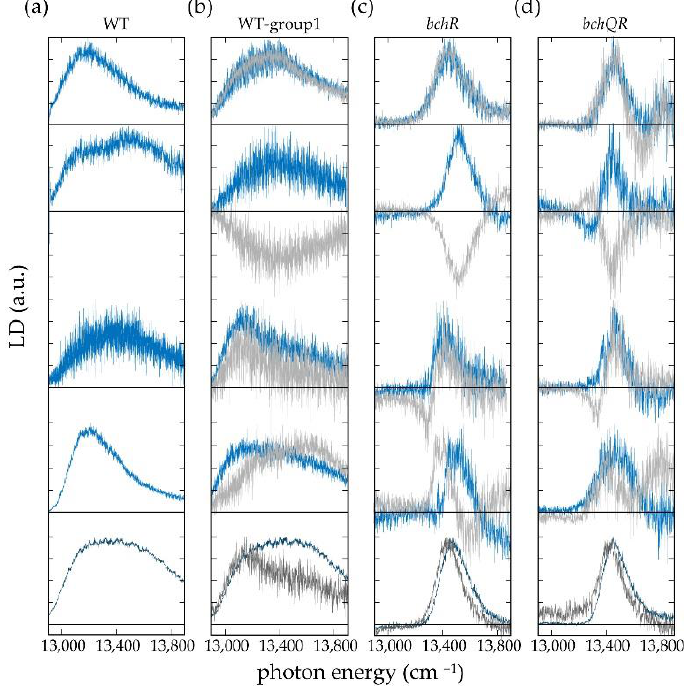
Figure 5. Reconstructed LD spectra using the central alignment direction obtained from the modulation of the fluorescence intensity at the maximum of the individual spectrum (light blue), or from the modulation of the Gaussian A 1 (light grey). The panel shows from left to right examples of LD spectra of individual chlorosomes from ( a ) WT, ( b ) WT-group1, ( c ) bchR , and ( d ) bchQR . The panel shows from top to bottom examples of LD spectra from individual chlorosomes that feature good agreement (A), good agreement but a sign flip (B), reasonable agreement (C), and no agreement for the two reconstruction methods (D). A–D refer to the classification used in Table 1. The spectra shown at the bottom in dark blue (dark grey) represent the corresponding ensemble spectra obtained by summing all individual LD spectra measured for chlorosomes of types ( a – d ) obtained according to method 1 (method 2). For each spectrum, the zero level is given by the horizontal line, and all spectra have been normalized for better comparison. Note in passing: For the WT chlorosomes, the comparison of the two reconstruction methods is not meaningful, because the spectral signatures of the WT-group2 chlorosomes, which account for about 26% of the total, do not fulfil the prerequisite of a tubular symmetry for the underlying molecular packing.